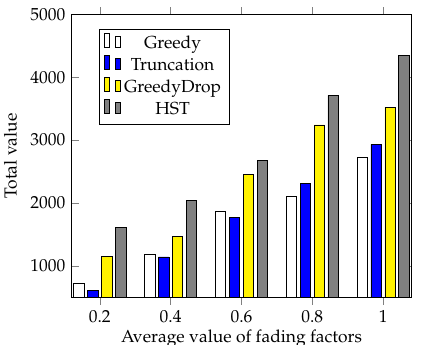
Figure 7. The effect of different average values of fading factors for FIFO tasks.